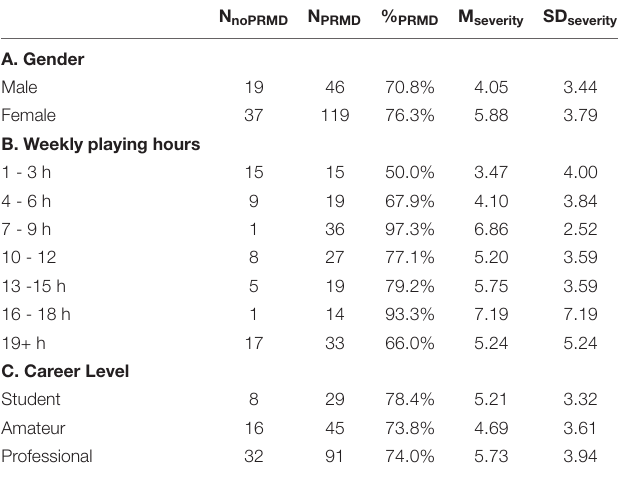
TABLE 2 | Descriptive statistics (Gender, Playing hours, and Career